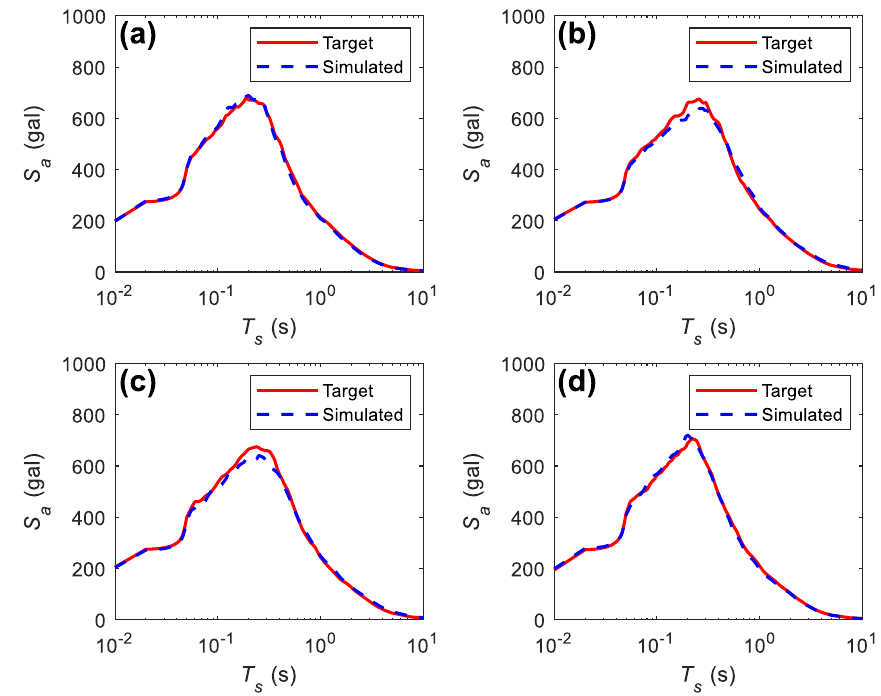
Fig. 8 Comparison of the acceleration response spectra in the numerical example: a site 2, b site 3, c site 5, and d site 6